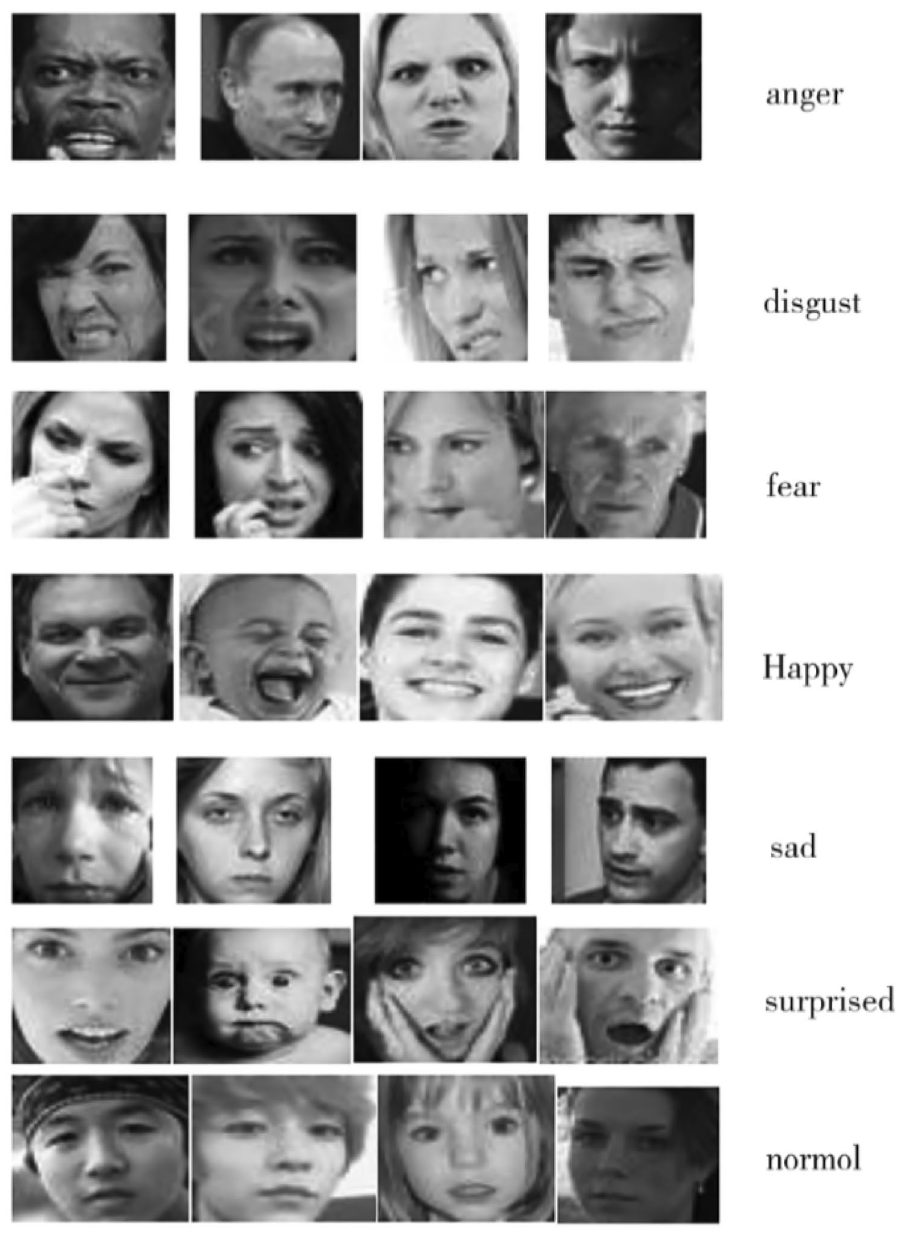
Fig. 1 Facial expression classification (samples from